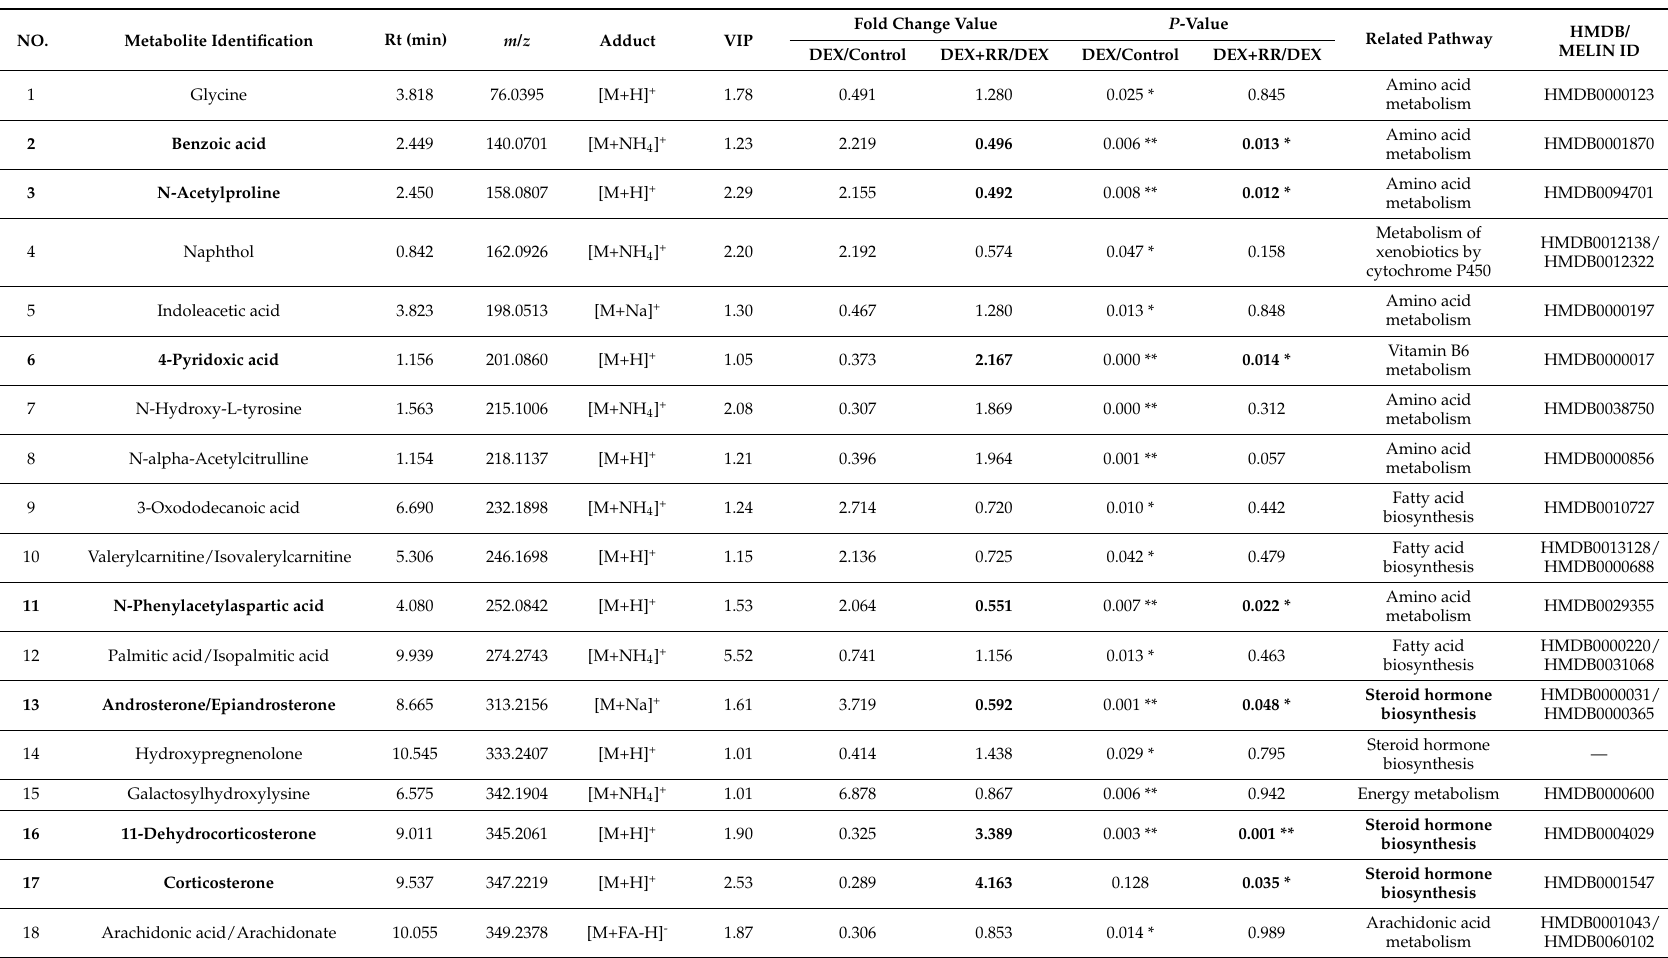
Table 1. Screening of potential biomarkers in rat